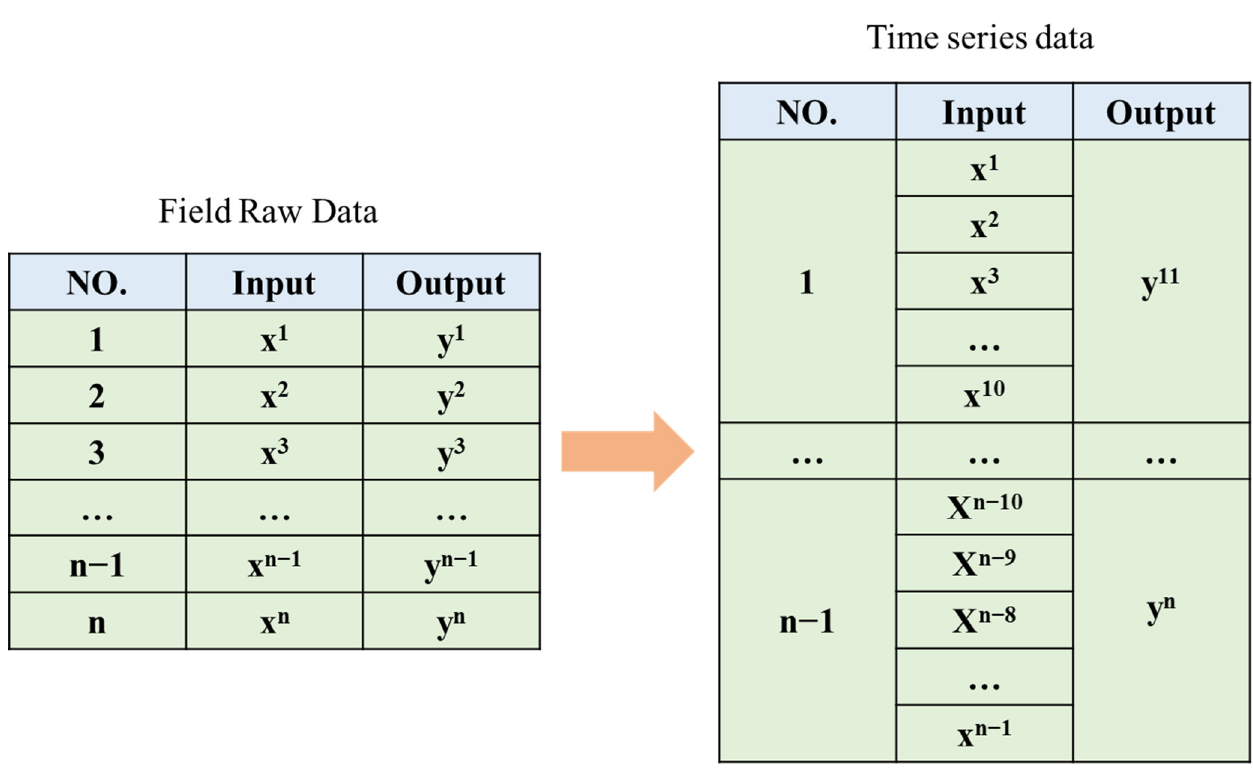
Figure 5. Schematic diagram of time series data construction.